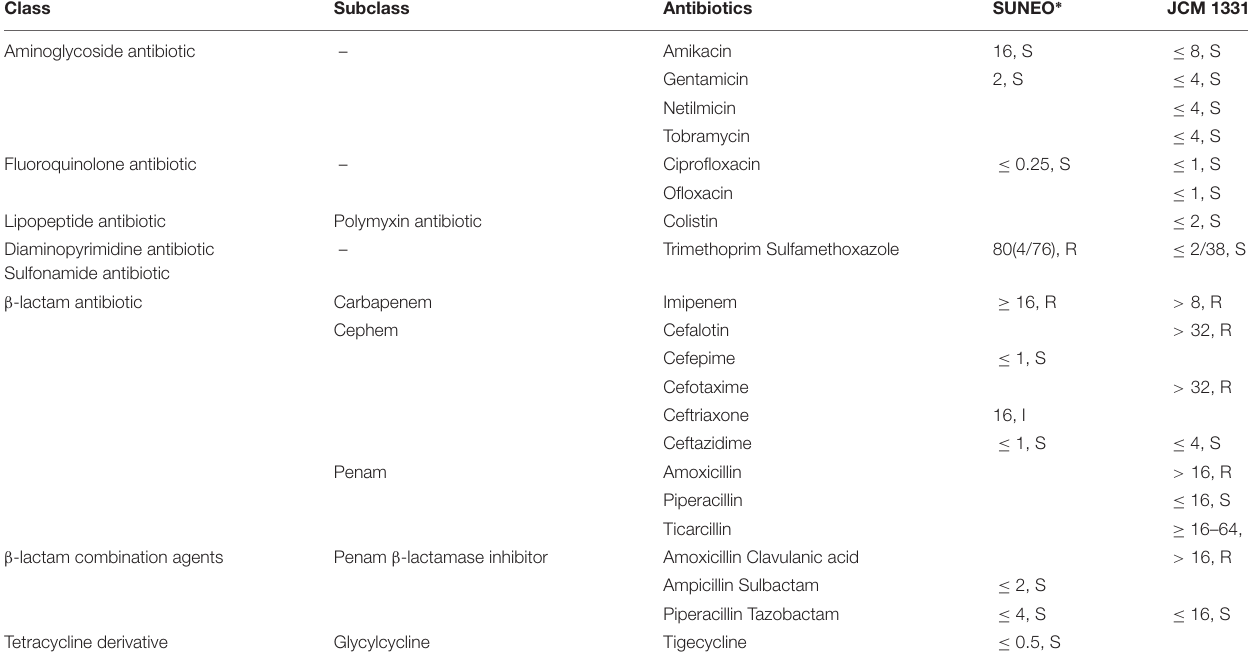
TABLE 3 | Antimicrobial susceptibility profiles of S. acidaminiphila SUNEO and JCM